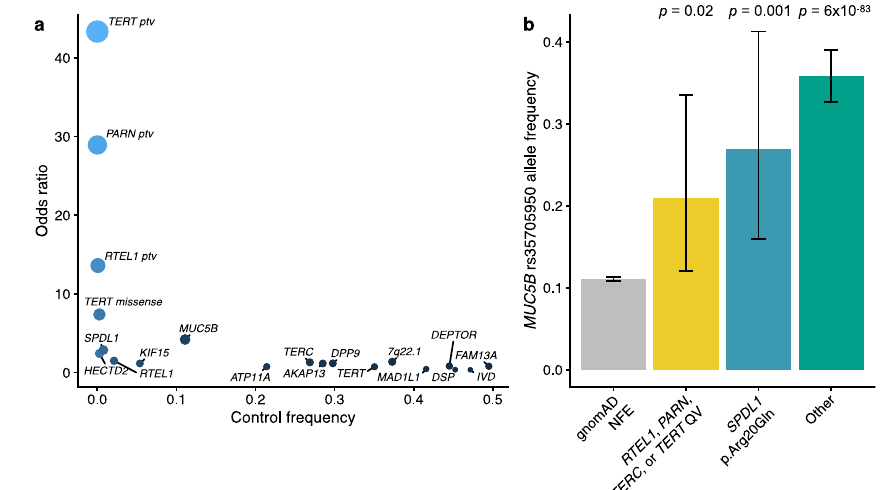
Fig. 3 Loci associated with IPF. a Scatter plot depicting the odds ratios versus control frequencies for: protein-truncating variants (PTVs) in TERT , PARN , and RTEL1 ; rare damaging missense variants in TERT based on PROFILE collapsing analyses; the novel missense variant in SPDL1 ; and the sentinel SNPs from the largest IPF GWAS to date 4 . Control frequencies for TERT , PARN , and SPDL1 missense re fl ect the carrier frequencies in the UK Biobank controls used for our association studies. Control frequencies for the remaining alleles were derived from gnomAD 21 non-Finnish European allele frequencies. b Allele frequency of the MUC5B promoter allele in 32,267 non-Finnish European gnomAD samples and 507 PROFILE IPF cases strati fi ed by genotype. “ Other ” refers to IPF cases who do not carry a rare variant in RTEL1 , PARN , TERC , TERT , and do not carry the SPDL1 missense variant (i.e., noncarriers). Fisher ’ s exact p-values are depicted for comparisons between gnomAD non-Finnish Europeans and QV carriers for each group. Error bars represent 95% con fi dence intervals.